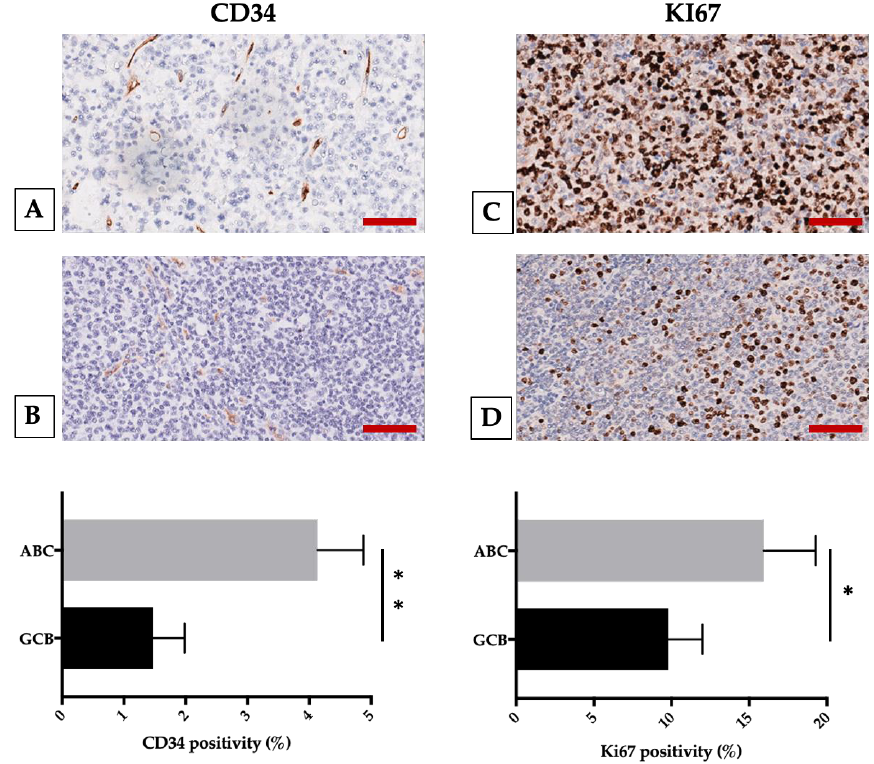
Figure 5. ABC (upper panel) and GCB (middle panel) DLBCL different expression of CD34 ( A , B ) and Ki67 ( C , D ) assessed by immunohistochemical staining. The morphometric analysis is expressed as marker percentage positivity (lower panel). Scale bar: A–D 60 µ m. Representative images from 60 untreated DLBCL patients are presented; * p < 0.05; ** p < 0.01, assessed by Mann – Whitney test [116].